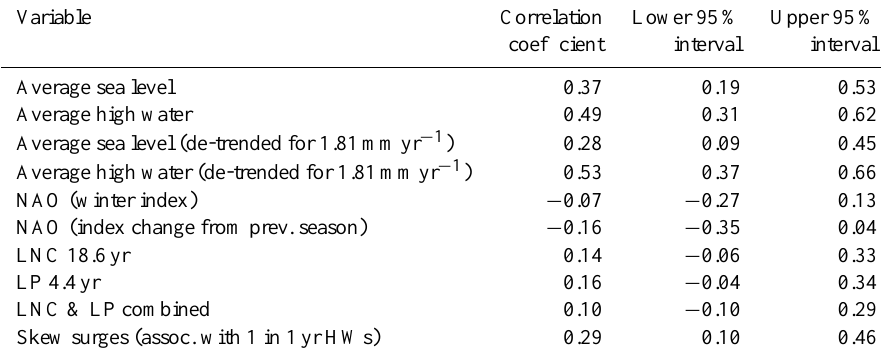
Table 5a. Correlation of the seasonal counts of high waters ≥ 1 in 1-year return period and various seasonal time series, with lower and upper 95% confidence intervals for each coefficient.